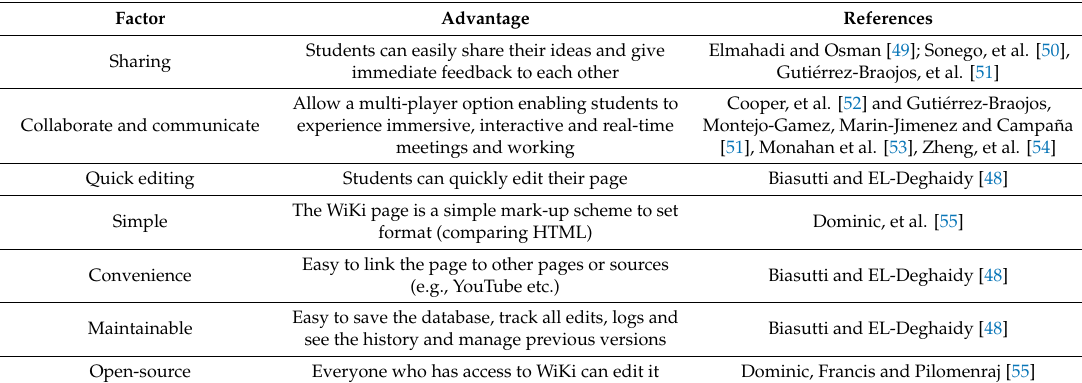
Table 2. Characteristics of the collaborative learning